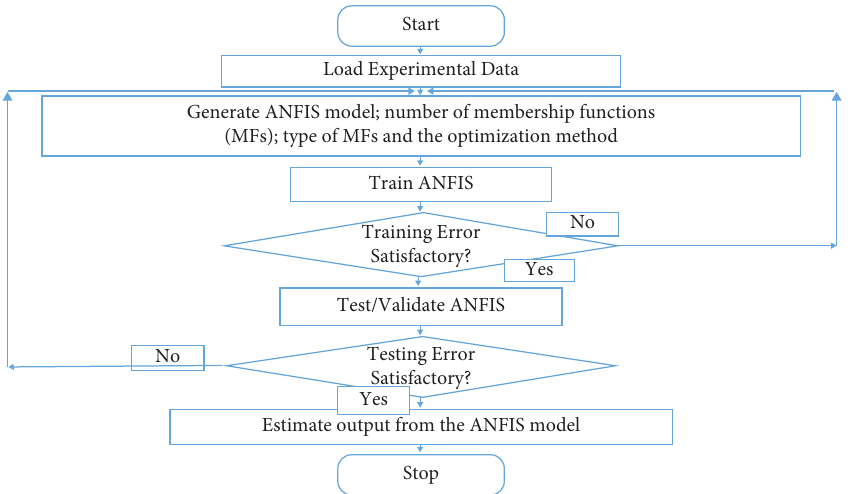
Figure 2: Computation fow chart implemented for ANFIS model development